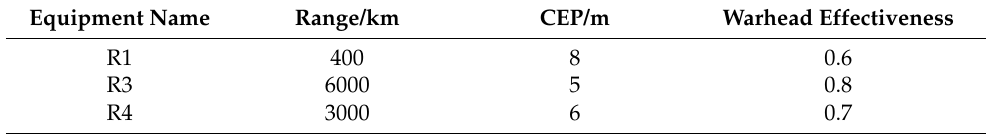
Table 6. Attributes of the red side’s attack nodes.